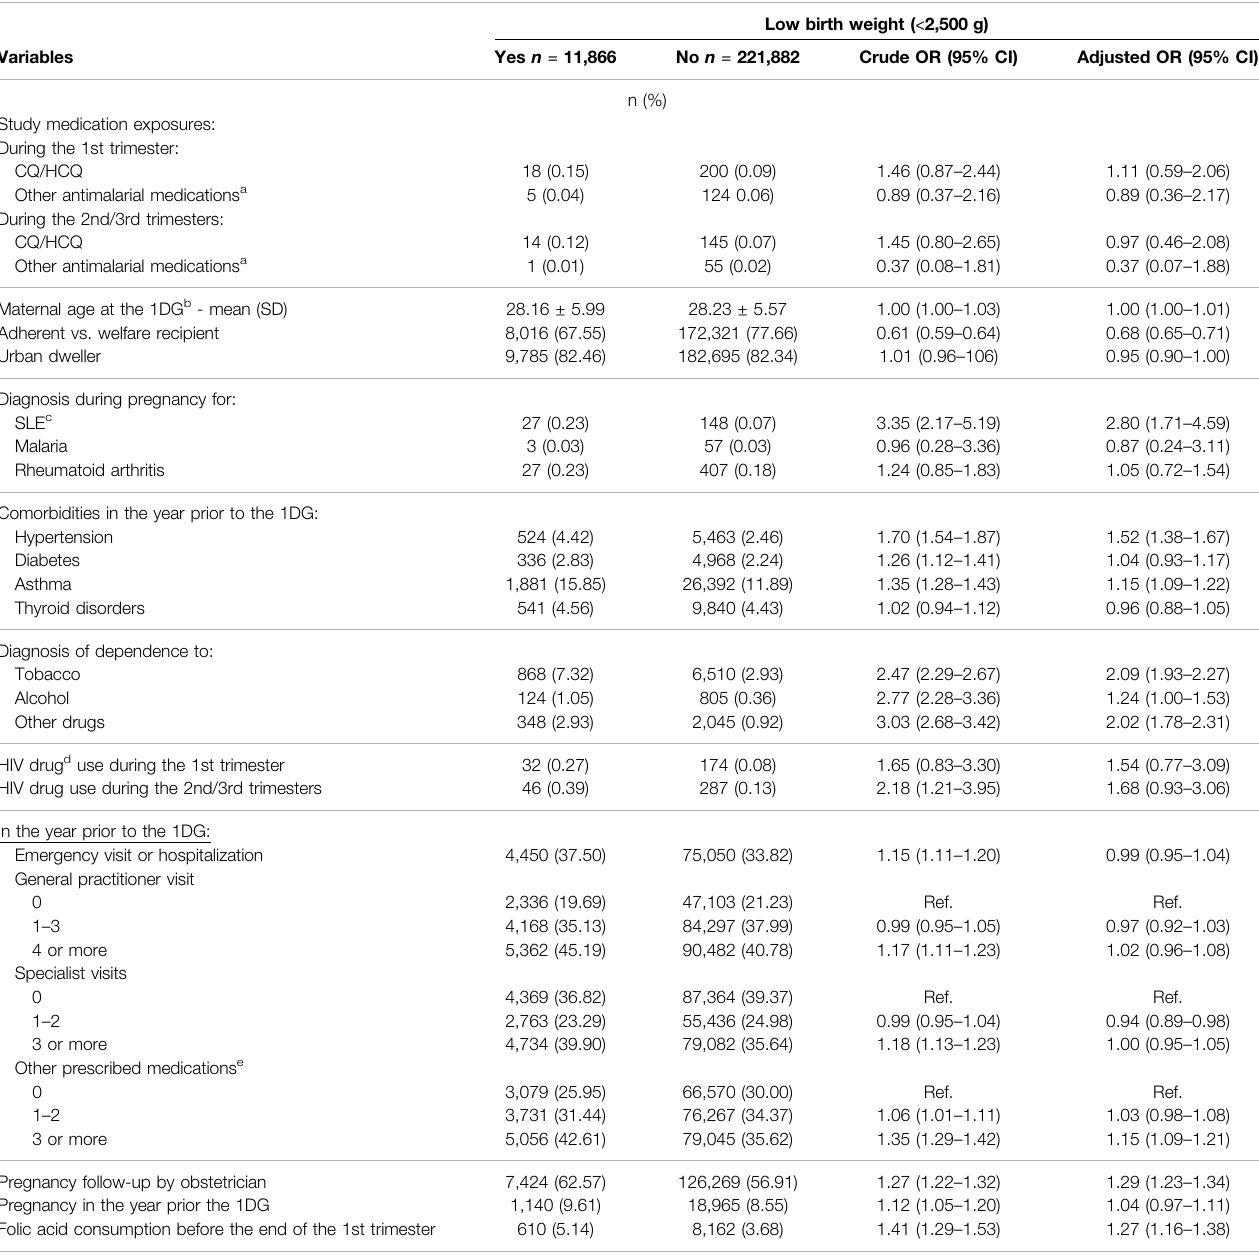
TABLE 3 | Association between CQ/HCQ exposure during pregnancy and the risk of